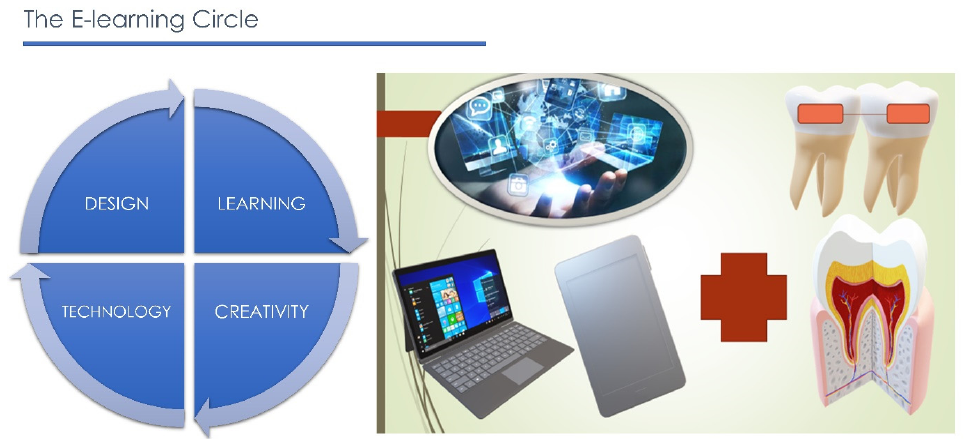
Figure 3. E-learning combination between telecommunication and medical field.